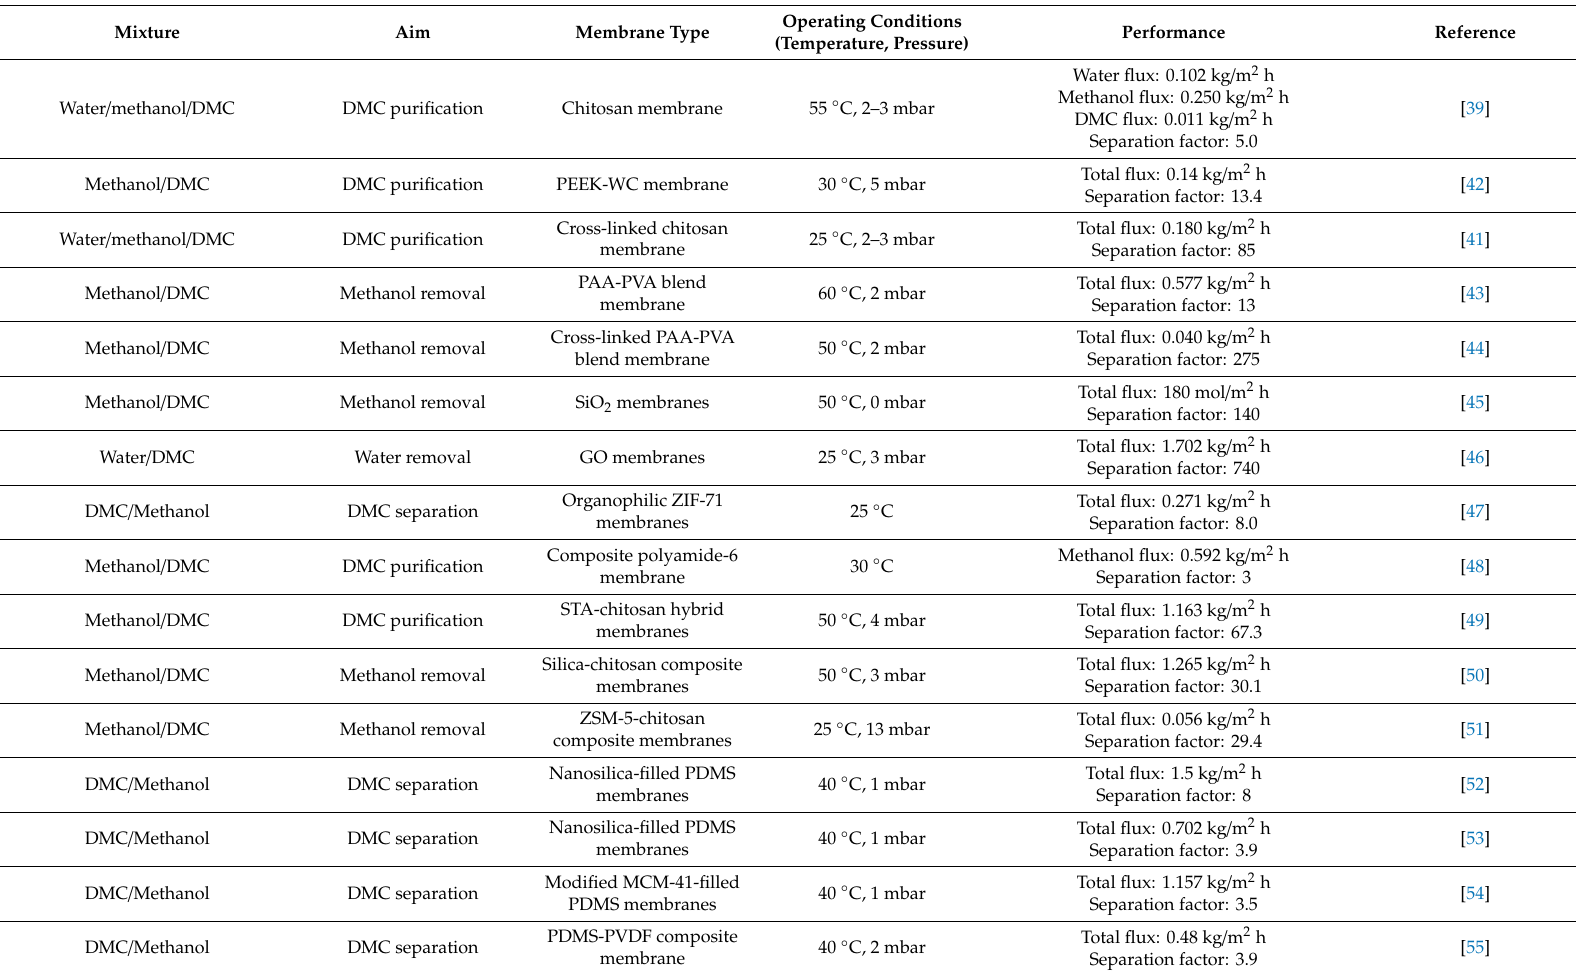
Table 1. Current findings of PV application aiming the separation of products derived from carbonylation